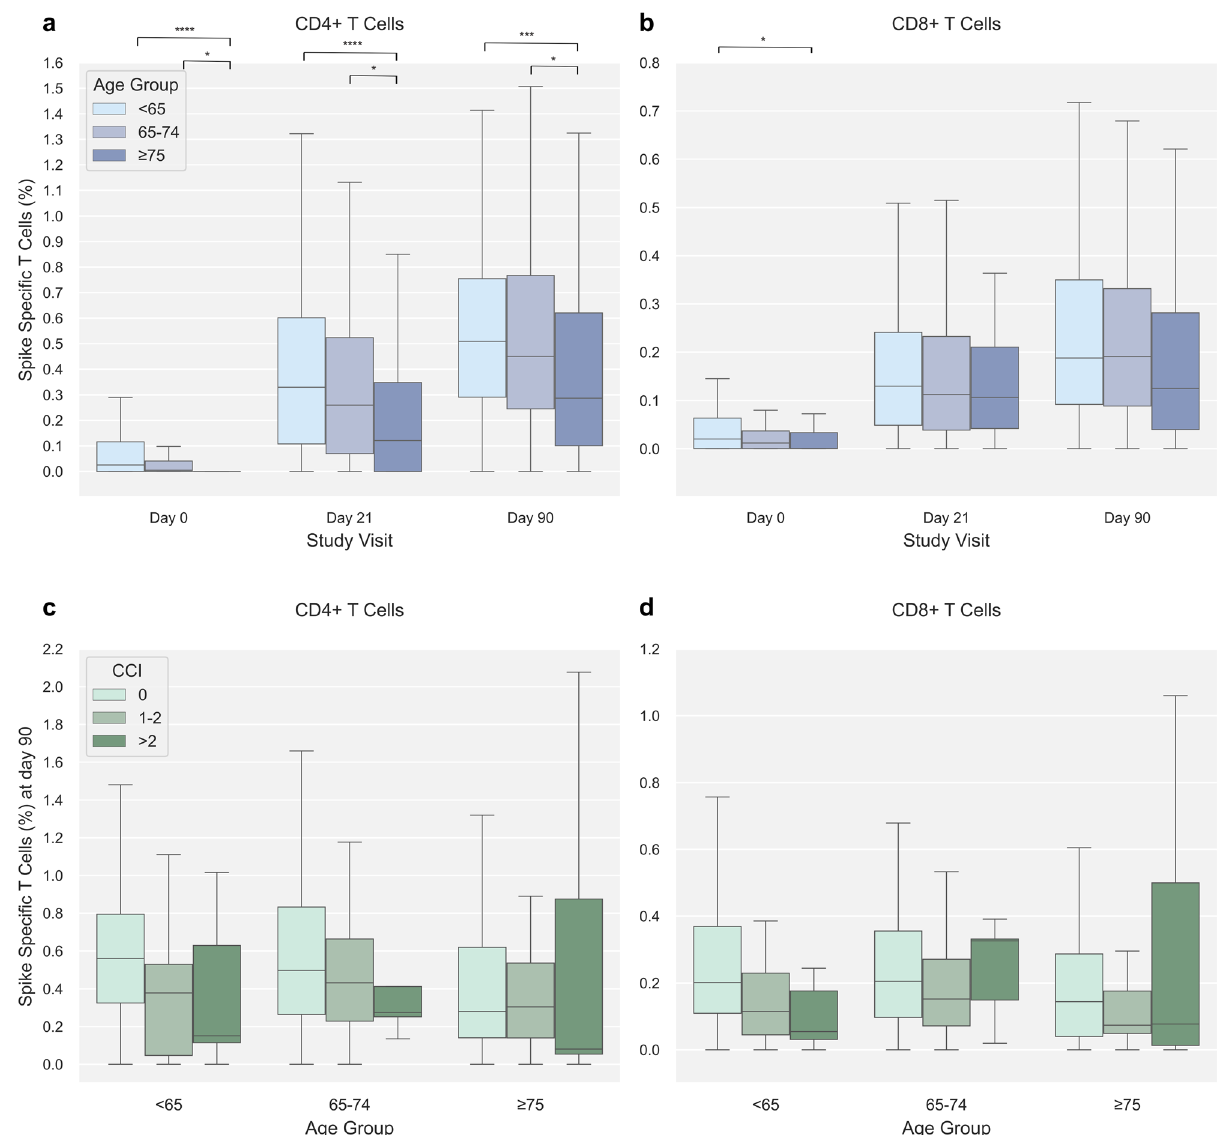
Fig. 2 SARS-CoV-2 Spike-speci fi c T cells with age and Charlson Comorbidity Index (CCI). a SARS-CoV-2 Spike-speci fi c CD4 + T cells at 0, 21, and 90 strati fi ed by age group (<65years [light blue], 65 – 74years [blue], ≥ 75years [dark blue]). Group sizes are; at day 0 n = 142 (<65years), n = 54 (65 – 74years), n = 90 ( ≥ 75years); at day 21 n = 234 (<65 years), n = 123 (65 – 74years), n = 103 ( ≥ 75years); at day 90 n = 214 (<65years), n = 134 (65 – 74years), n = 114 ( ≥ 75years). b SARS-CoV-2 Spike-speci fi c CD8 + T cells at 0, 21, and 90 strati fi ed by age group (<65years [light blue], 65 – 74years [blue], ≥ 75years [dark blue]). Group sizes are; at day 0 n = 139 (<65years), n = 54 (65 – 74years), n = 79 ( ≥ 75years); at day 21 n = 233 (<65years), n = 118 (65 – 74years), n = 93 ( ≥ 75years); at day 90 n = 213 (<65years), n = 130 (65 – 74years), n = 106 ( ≥ 75years). c SARS-CoV-2 Spike-speci fi c CD4 + T cells at day 90 in the three age groups strati fi ed by Charlson Comorbidity Index (CCI) (CCI = 0 [light green], CCI = 1 – 2 [green], CCI >2 [dark green]). Group sizes are; in age group <65years n = 175 (CCI = 0), n = 30 (CCI = 1 – 2), n = 9 (CCI> 2); age group 65 – 74years n = 88 (CCI = 0), n = 37 (CCI = 1 – 2), n = 5 (CCI> 2); age group ≥ 75 n = 79 (CCI = 0), n = 21 (CCI = 1 – 2), n = 6 (CCI> 2). d SARS-CoV-2 Spike-speci fi c CD8 + T cells at day 90 in the three age groups strati fi ed by CCI (CCI = 0 [light green], CCI = 1 – 2 [green], CCI> 2 [dark green]). Group sizes are; in age group <65years n = 175 (CCI = 0), n = 29 (CCI = 1 – 2), n = 9 (CCI> 2); age group 65 – 74years n = 88 (CCI = 0), n = 37 (CCI = 1 – 2), n = 5 (CCI> 2); age group ≥ 75 n = 79 (CCI = 0), n = 21 (CCI = 1 – 2), n = 6 (CCI>2). Data was compared using unpaired, non-parametric Mann – Whitney U -test. Error bars show the distribution within 1.5 times IQR.